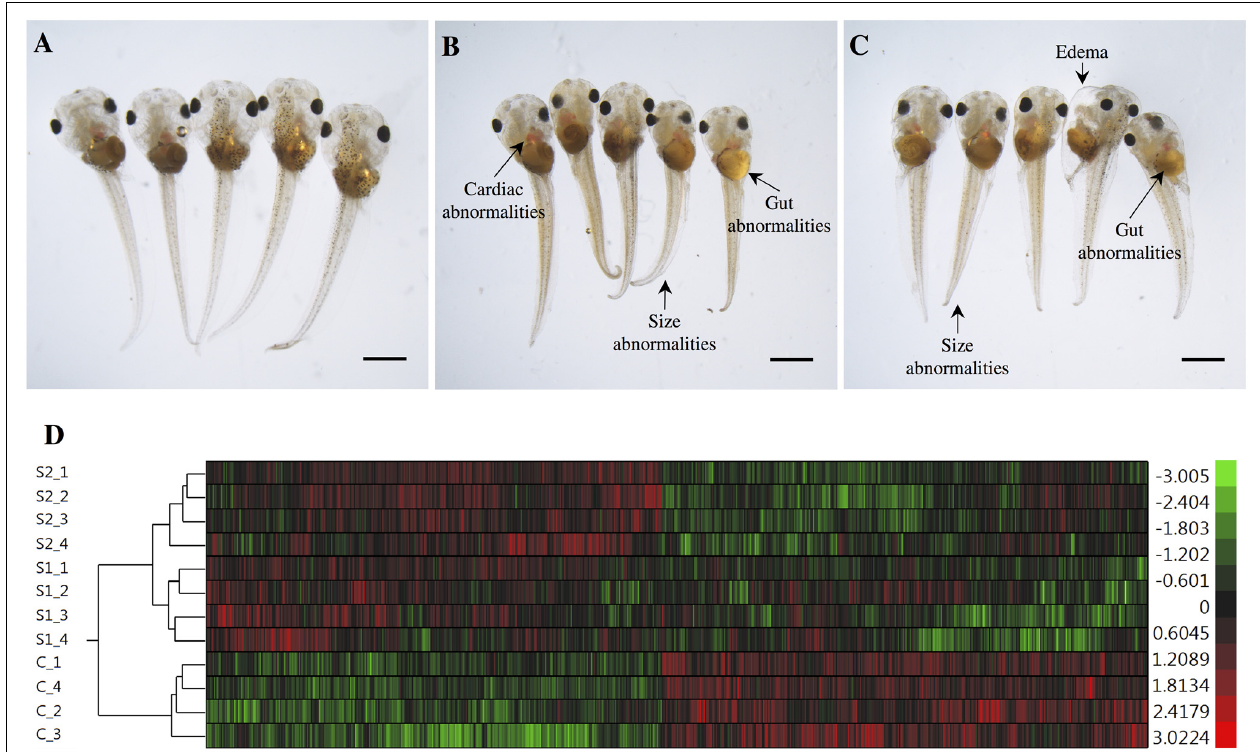
FIGURE 1 | Photographs of Silurana ( Xenopus ) tropicalis indicating the main teratogenic effects induced by exposure to NAs, control (A) , S1 (B) , and S2 (C) . Scale bar is equal to 1 mm in (A–C) . Some of the observed abnormalities are indicated with arrows. Hierarchical clustering of gene expression data using gene probes that were differentially expressed ( p < 0.05) in S. tropicalis embryos exposed to two mixtures of NAs (S1 and S2) during early embryonic development versus control samples (C1–4) in (D) . In panel (D) columns represent individual genes and rows represent a treatment replicate. Each cell in the matrix represents the expression level of a gene feature in an individual replicate. The red or green color in cells reflects relative high or low expression levels, respectively, as indicated in the scale bar.